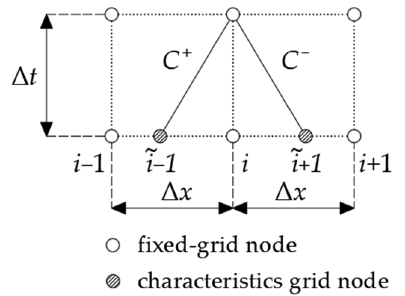
Figure 8. Numerical grid in fixed-grid method of characteristics.